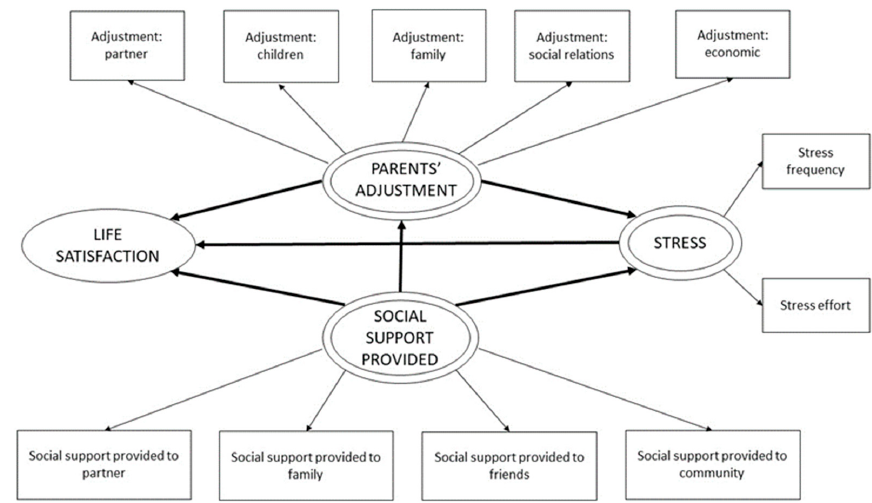
Figure 2. Conceptual model of social support provided.